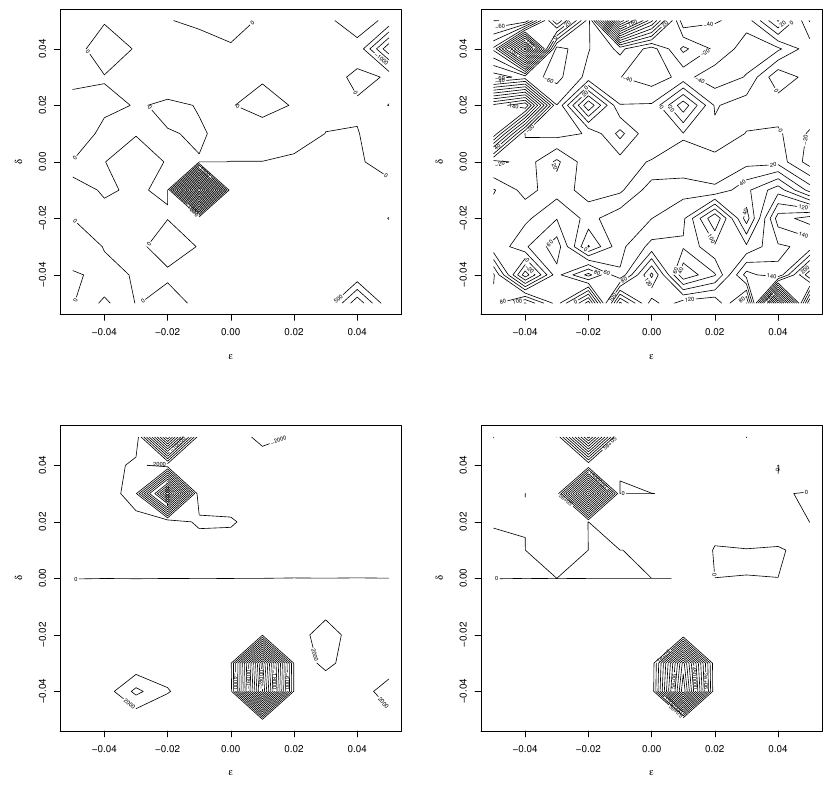
Figure 4 – Contours of the relative percentage changes in the bias of the estimator of α (top left), the MSE of the estimator of α (top right), the bias of the estimator of β (bottom left) and the MSE of the estimator of β (bottom right) when n =